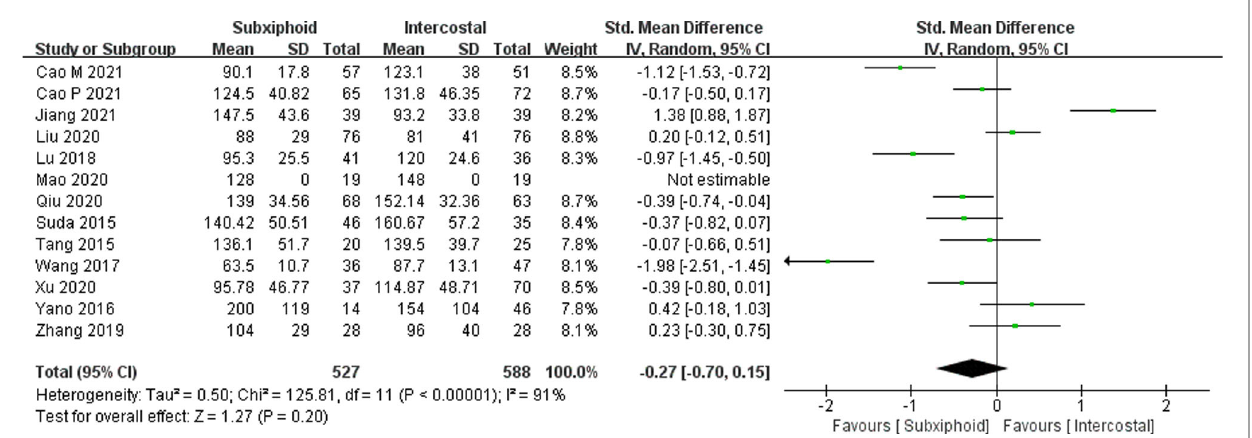
FIGURE 5 | Forest plot of the role of SMD and its 95% CI of operation time between SVATS and IVATS groups.